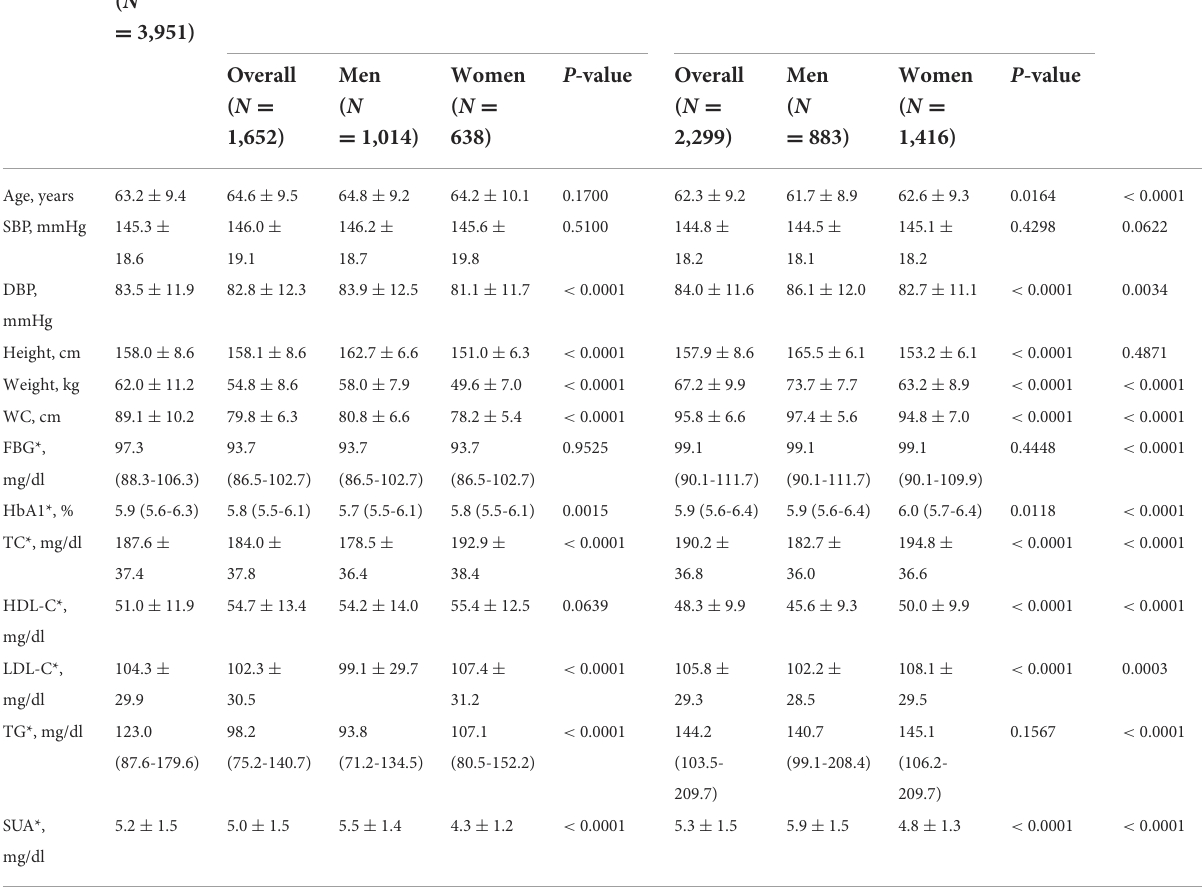
TABLE 5 Basic characteristics of the non-obesity-related hypertensive and obesity-related hypertensive patients. Variable Non-obesity-related hypertension Obesity-related hypertension P